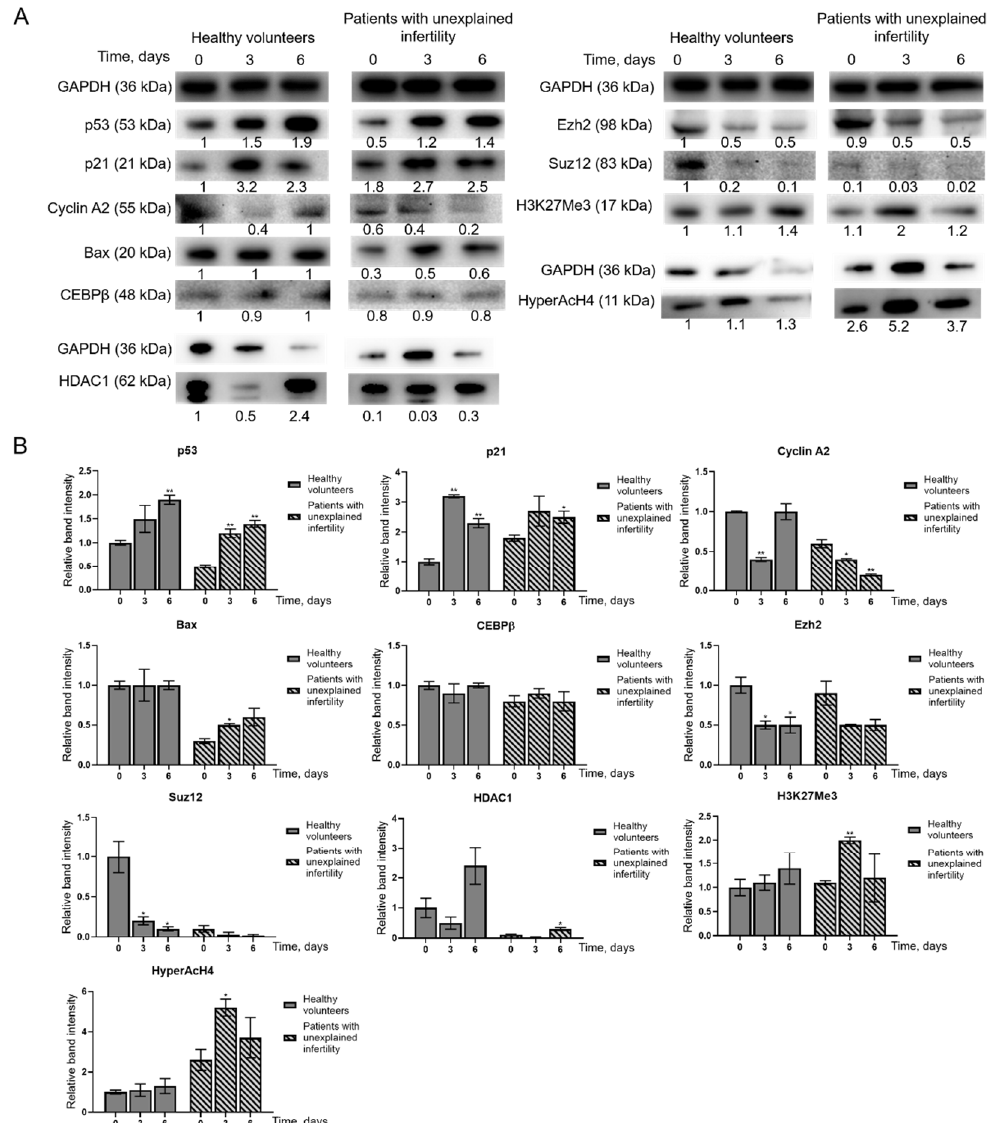
Figure 7. Evaluation of changes in protein levels. In each study group n = 2. ( A ) C—control cells, 3—proteins isolated from MenSCs after 3 days in differentiation medium, 6—proteins isolated from MenSCs after 6 days in differentiation medium. GAPDH is a control protein. The intensity of the protein bands was estimated by the ImageJ program, and the levels of each protein were calculated according to the GAPDH. ( B ) Densitometric analysis graphs of relative band intensity of detected protein levels as measured using ImageJ software and normalized to the GAPDH loading control; results are mean ± S.D. * p ≤ 0.05; ** p ≤ 0.01, based on t -test.